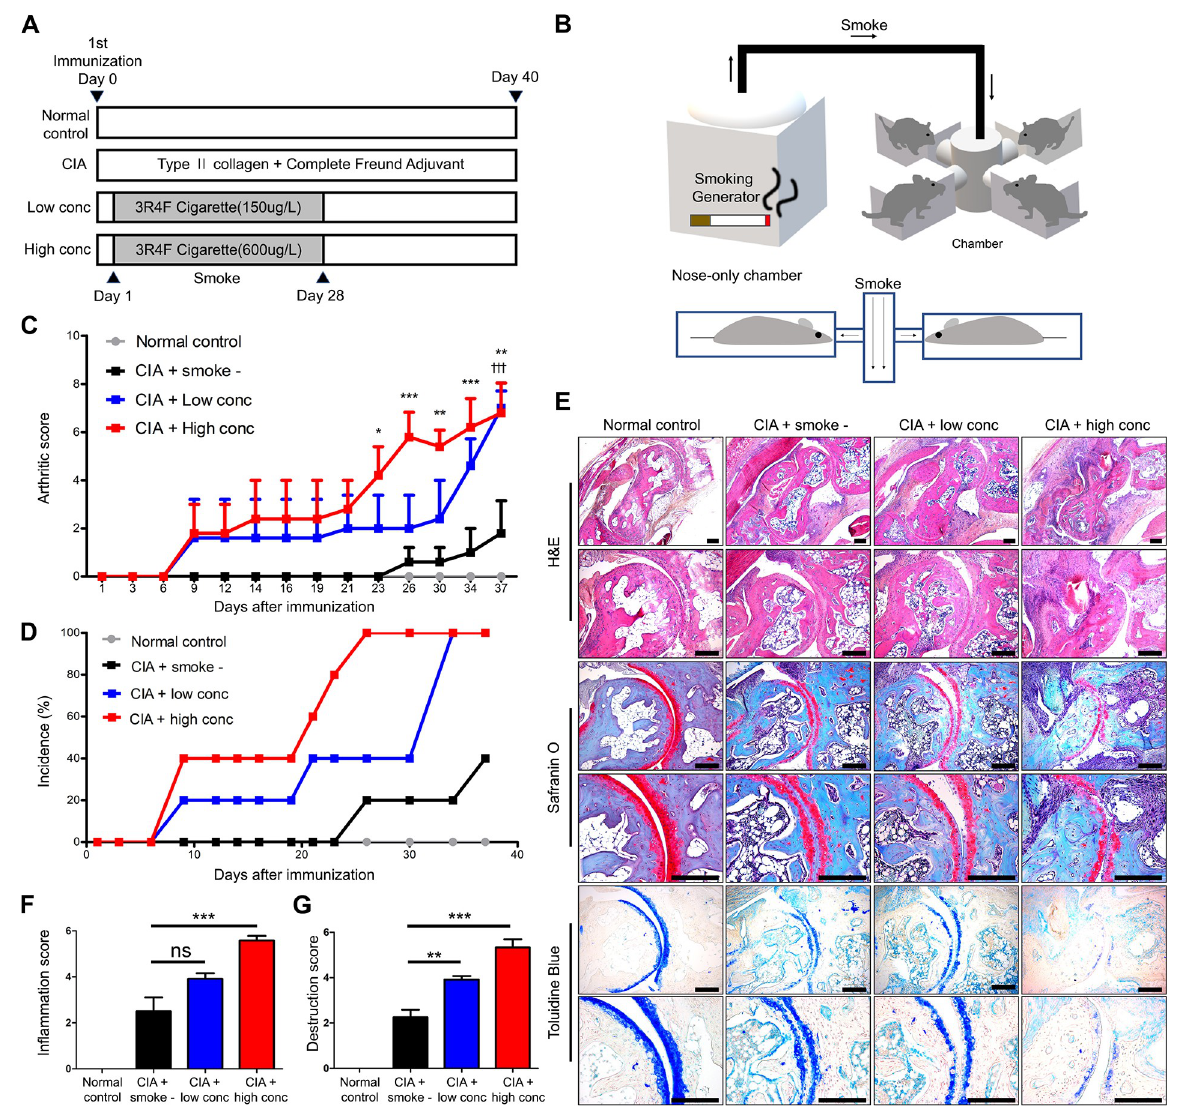
Fig 1. Cigarette smoke exacerbates rheumatoid arthritis in a collagen-induced arthritis (CIA) mouse model. (A) Scheme of the experimental concept of CIA induction and cigarette smoke inhalation. (B) Schematic diagram of cigarette smoke inhalation chamber. CIA mice were placed in a nose-only exposure smoke chamber. All mice were made to inhale cigarette smoke for one hour per day for 4 weeks. (C) The arthritic score was calculated 2 times per week in the experimental period. Using established criteria, each paw was given an arthritic score that ranged from 0 to 4, and the scores from all 4 paws were summed. (D) The incidence of arthritis was calculated according to the percentage of swollen and inflammatory paws of each mouse. (E) Histological analysis was conducted by H&E, safranin O, and toluidine blue staining of the tarsal joint in the hind paws. (F) Inflammation score showed the extent of synovial hyperplasia and infiltration of immune cells such as leukocytes. (G) Destruction score showing loss of cartilage according to safranin O and toluidine blue staining. Histological scores were calculated by three researchers in a blinded manner. Data are the mean ± SEM, ††† p < 0.001, CIA versus CIA with low concentration of smoke, � p < 0.05; �� p < 0.01; ��� p < 0.001, CIA versus CIA with high concentration of smoke by repeated statistical analysis and multiple groups by one-way ANOVA. CIA, collagen-induced arthritis. Scale bars, 200 μ